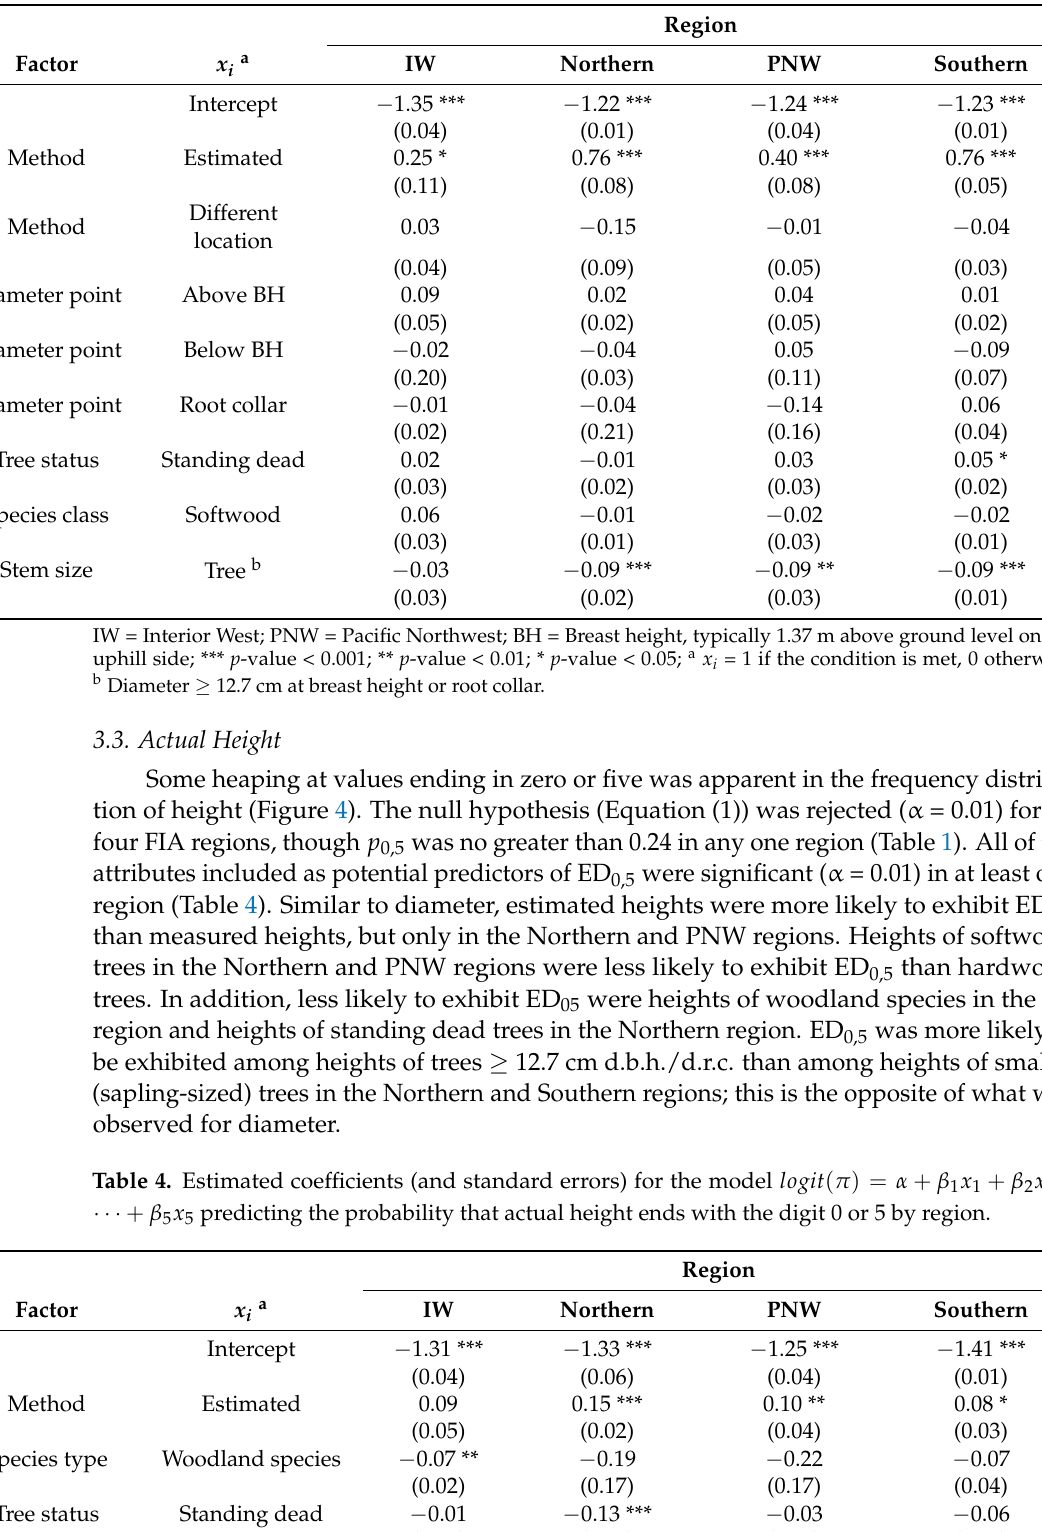
Table 3. Estimated coefficients (and standard errors) for the model logit ( π ) = α + β 1 x 1 + β 2 x 2 + · · · + β 8 x 8 predicting the probability that diameter ends with the digit 0 or 5 by region.